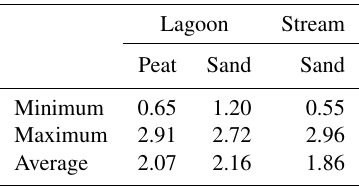
Table 1. Summary of measured thermal conductivity ( k e ) in differ- ent sediment types at the two field sites. The values are given in Wm − 1 ◦ C − 1